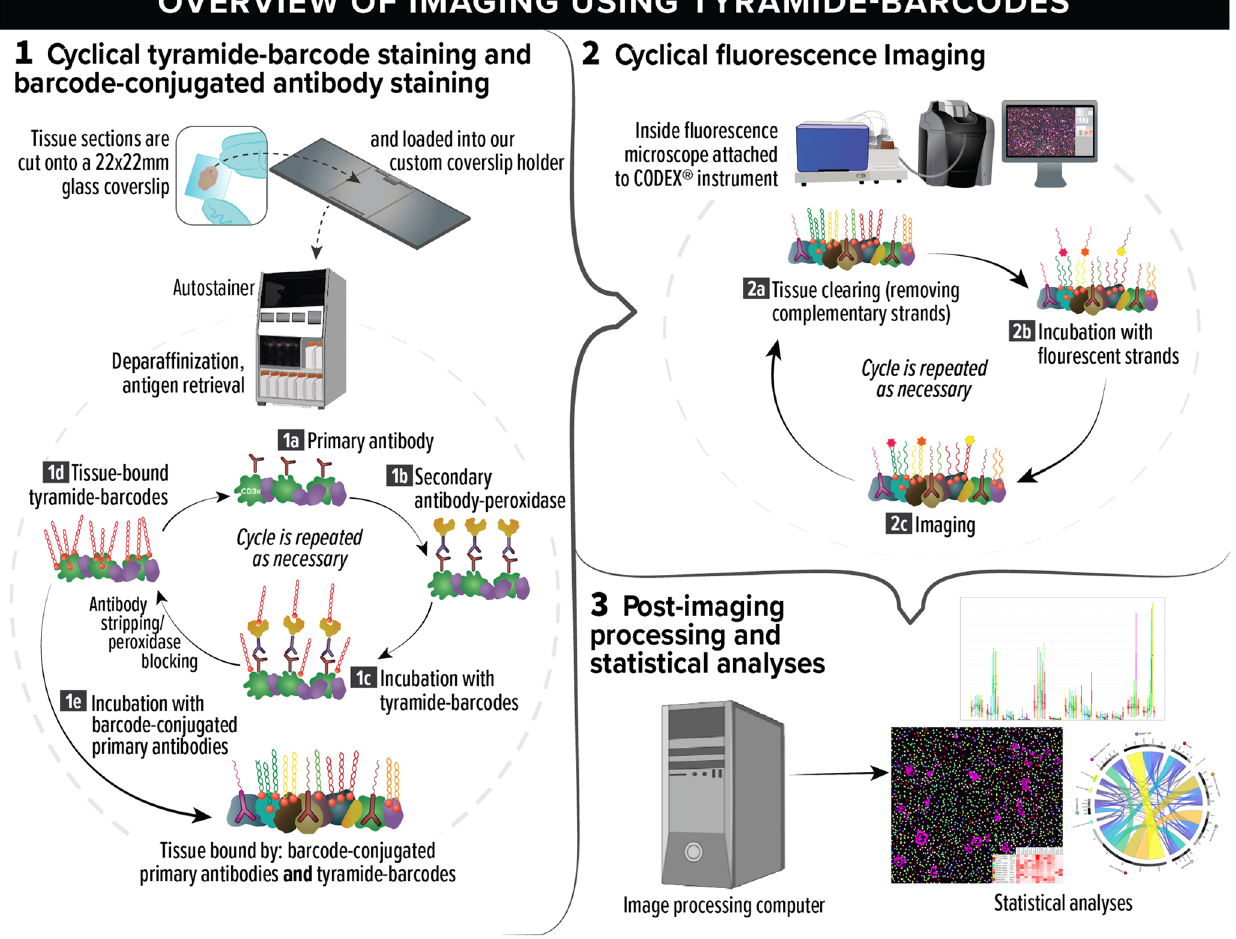
Fig. 1 Multiparametric imaging with tyramide-barcodes and barcode-conjugated antibodies. The process can be divided into three stages: (1) tissue staining with tyramide-barcodes and barcode-conjugated antibodies, (2) cyclical fl uorescence imaging, and (3) image processing and statistical analysis. In stage 1, tissue is cut into thin sections and placed on microscope coverslips. The coverslips are then loaded onto our custom coverslip holders, which allow processing in a tissue autostainer. Paraf fi n-embedded tissue is deparaf fi nized, after which antigen retrieval is performed. Cyclical tyramide-barcode staining is then repeated (steps 1a – 1d) for as many primary antibodies as desired for signal ampli fi cation and/or unmodi fi ed primary antibody use. In step 1a, the tissue is incubated with an unmodi fi ed primary antibody. In step 1b, the tissue is incubated with peroxidase-conjugated secondary antibodies. In step 1c, the peroxidase (attached to the secondary antibodies) enzymatically activates the tyramide, and tyramide-barcodes bind to the tissue in close proximity to the peroxidase. The peroxidase is then permanently inactivated and/or the antibodies are removed, and the cycle can begin again at step 1a for a different primary antibody, or, if there are no more primary antibodies for signal ampli fi cation, staining proceeds to step 1e. In step 1e, the tissue is incubated with a cocktail of many barcode-conjugated primary antibodies. The tissue is lightly fi xed to lock antibodies into place, and the process then moves on to stage 2. In step 2a, tissue clearing is performed, in which double-stranded DNA barcodes are dissociated, and the non-covalently attached strands are washed away. In 2b, one to three unique single-stranded DNA barcodes are incubated with the tissue, each one conjugated to one of three different fl uorophores and complementary to one of the tissue-attached barcodes. After incubation, the tissue is imaged by fl uorescence imaging, step2c. By imaging only a small subset of the barcodes in each cycle, high quality imaging of each target antigen can be achieved without signi fi cant spectral overlap of fl uorescence signals. Steps 2a – 2c are repeated until all of the antigens have been imaged. Stage 3 then commences, comprising post-imaging image alignment, stitching, and segmentation, followed by additional study-speci fi c statistical analyses. Elements of the fi gure are from Biorender scienti fi c illustration